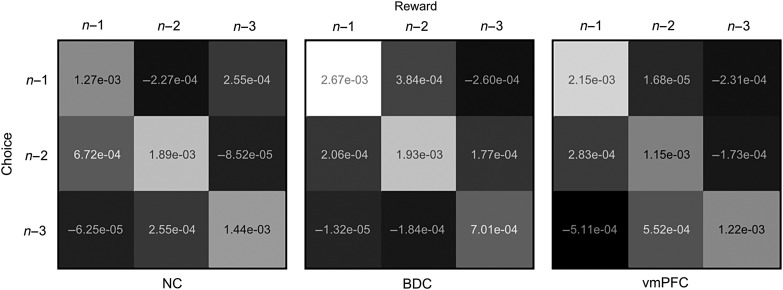
Results of logistic regression analysis designed to assess contingent learning. Contingent learning refers to the formation of discrete associations between an individual choice (e.g., on the last, n−1, trial) and its specific outcome (i.e., on the n−1 trial), as opposed to false associations between different trials (e.g., n−2) and other outcomes (e.g., n−3 trial). The matrices (left: NC, center: BDC, and right: vmPFC group) show the magnitude of regression coefficients (white = large and black = small) relating to the association of each of the 3 past reward outcomes with each of the past 3 choices. Squares on the diagonal, therefore, relate to contingent learning: that is, veridical associations between a specific trial (e.g., n−1) and the specific outcome received (at n−1 trial). Off-diagonal components index the strength of false associations: for example, the bottom left square relates to the association of the reward received on the last trial (n−1) with the choice made on the n−3 trial. As such, a high magnitude coefficient indexed by this component would indicate that if fractal A had been chosen 3 trials in the past, then receiving a large reward on the last trial would increase the log odds of selecting fractal A on the next trial, irrespective of which fractal was chosen on the n−1 trial and what reward was received on the n−3 trial. See the main text for details.